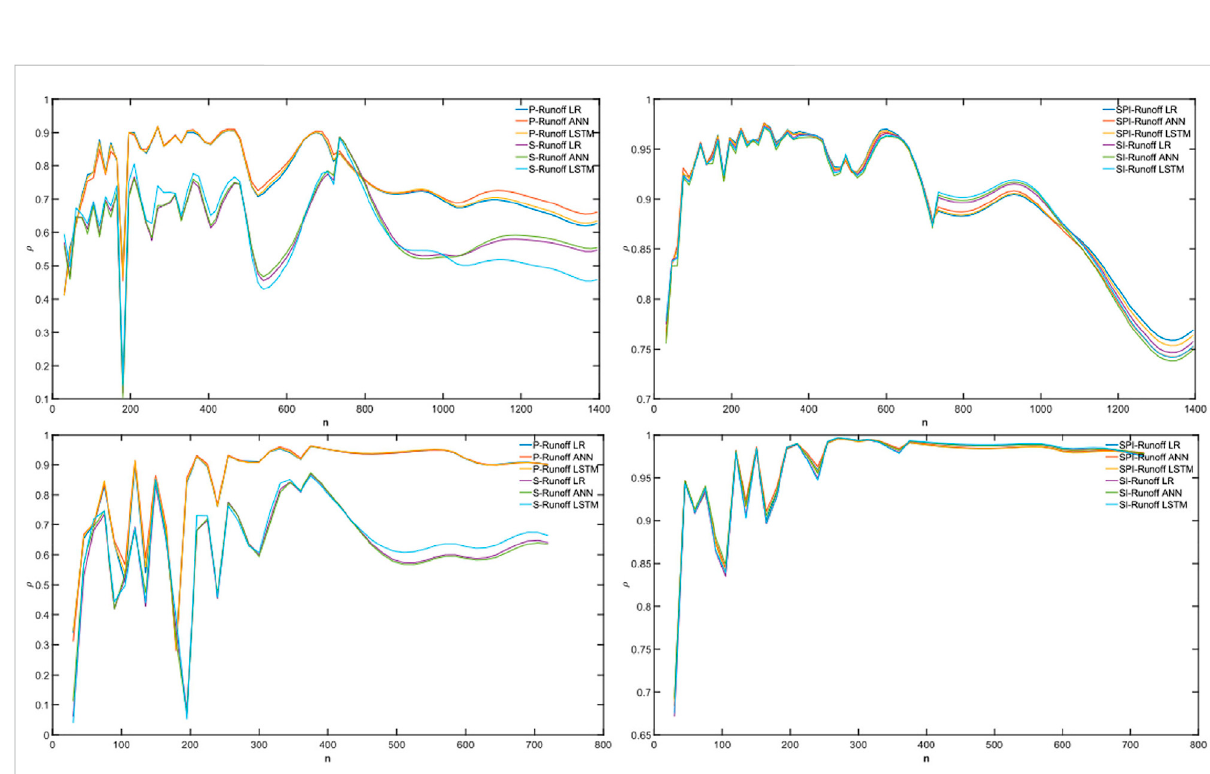
FIGURE 16 ρ DCCA between reconstructed runoff derived from P, S (upper-left), reconstructed runoff derived from SPI, SI (upper-right), forecasted runoff derived from P, S (lower-left), and forecast runoff derived from SPI, SI (lower-right) and in-situ Kratie